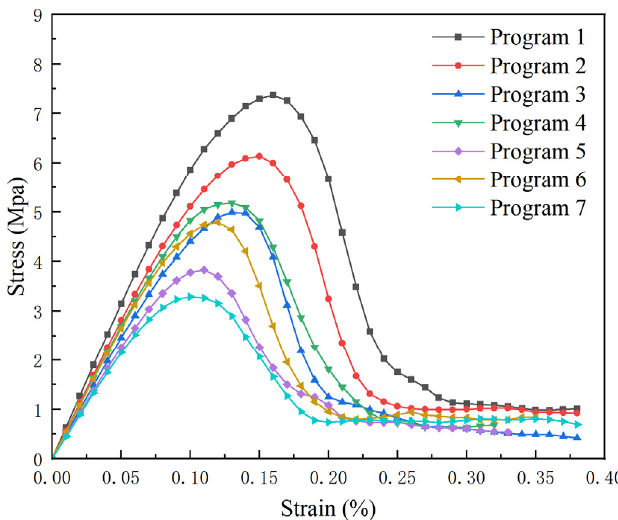
Figure 9. Stress–strain curves of materials with different pore characteristics. Table 3. Test results for material elastic modulus E and plastic softening modulus λ